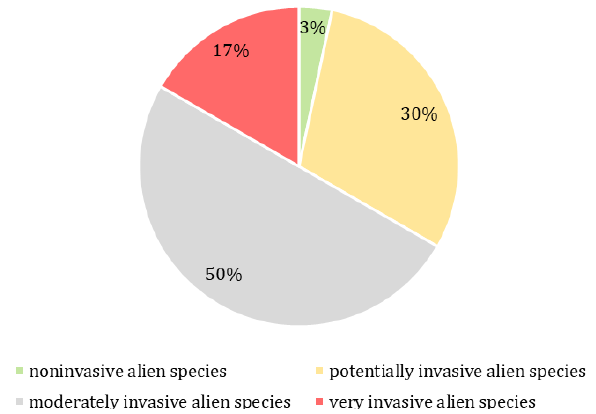
Fig. 5. The level of invasiveness of invasive alien plant species in Poland assigned to the species analysed on the basis of the Harmonia +PL